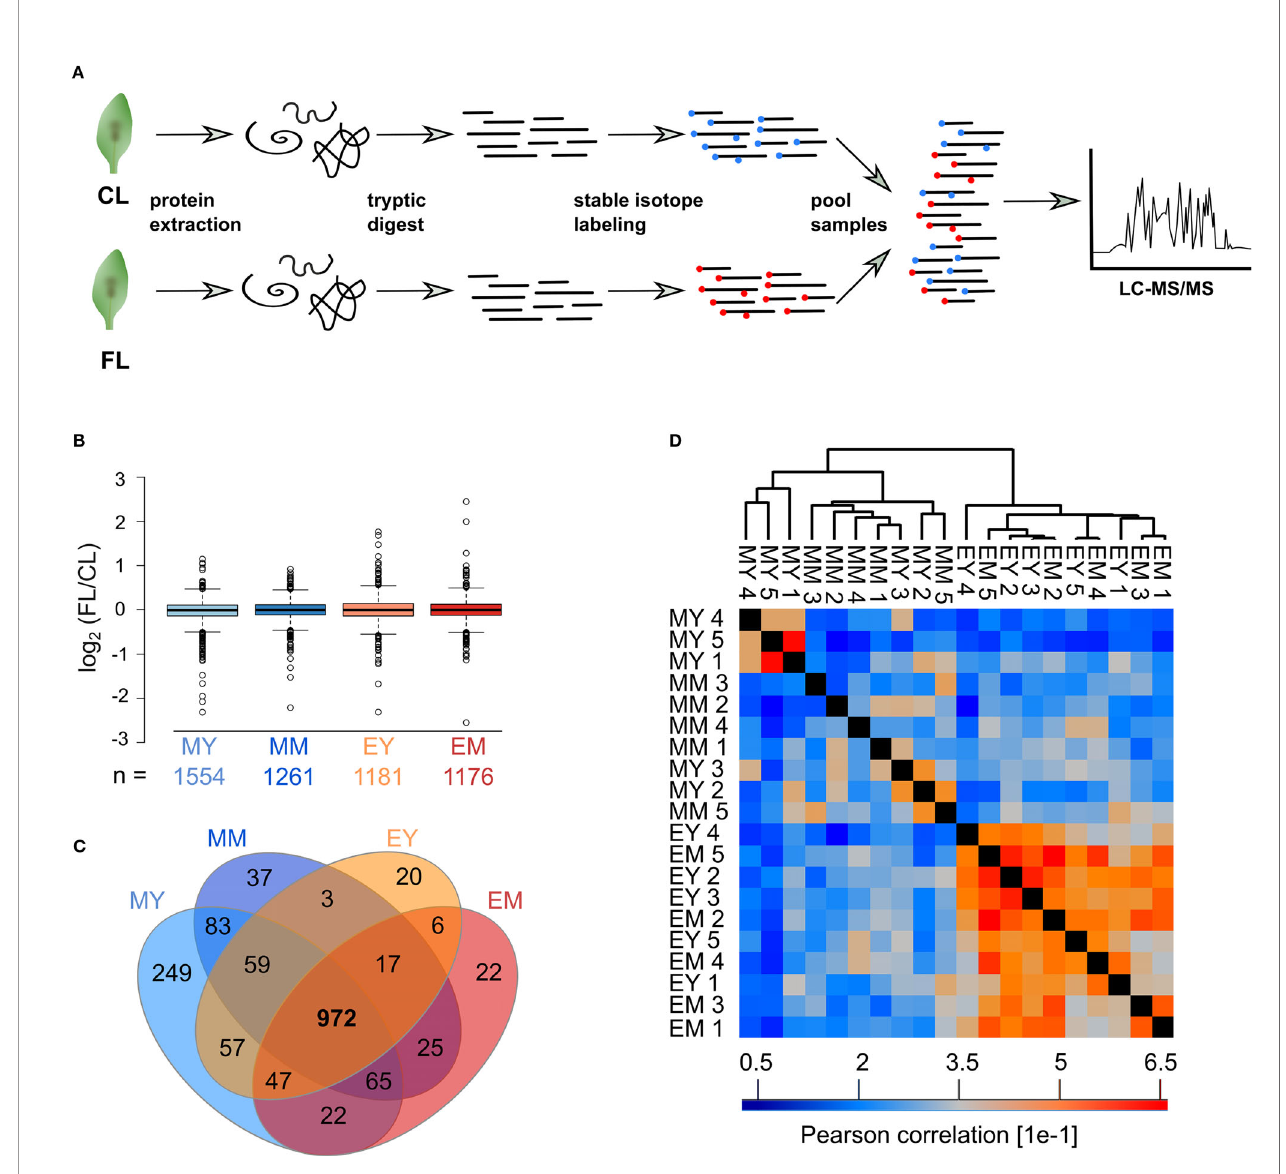
FIGURE 2 | Proteomics work fl ow and overview of the FL experiment dataset. (A) Proteins were extracted, digested into peptides and CL and FL samples differentially stable isotope labeled with formaldehyde reagents before randomized pairwise pooling of FL and CL proteomes for analysis by nanoLC-MS/MS. (B) Median normalized FL/CL ratios of proteins quanti fi ed in atleast three of the fi ve biological replicates of each sample. Whiskers extend to 5th and 95th percentile. (C) Overlap of proteins quanti fi ed in at least three out of fi ve replicates in the four samples. (D) Pearson correlation of protein ratios between the biological replicates of the 972 proteins that were quanti fi ed in at least three replicates for every